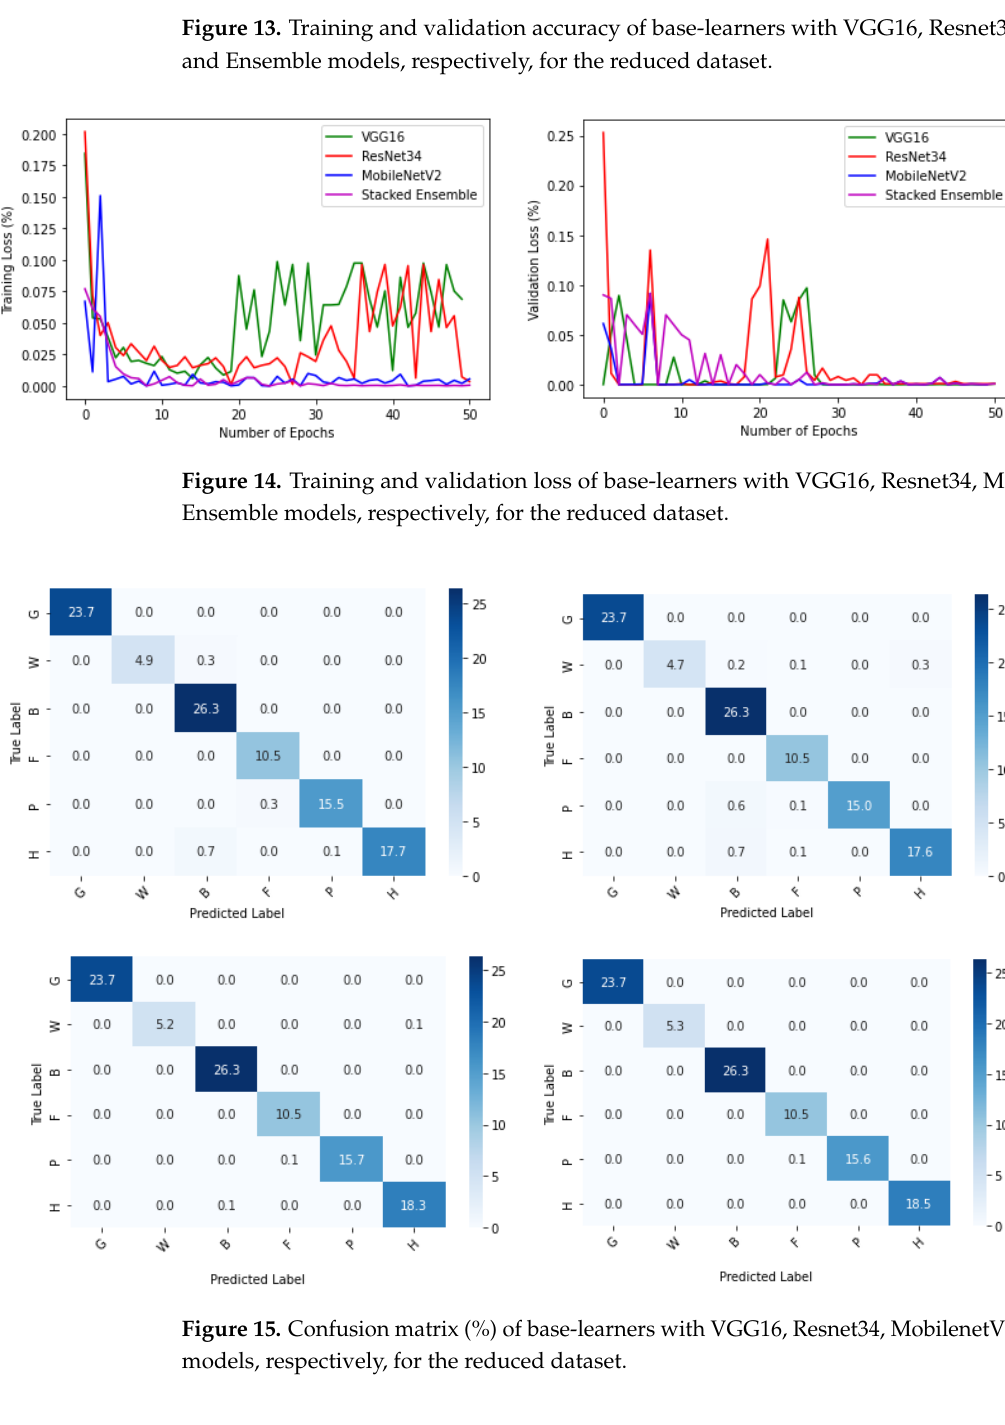
Figure 16. ROC curve and AUC values of base-learners with VGG16, Resnet34, MobilenetV2, and Ensemble models, respectively, for the reduced dataset.